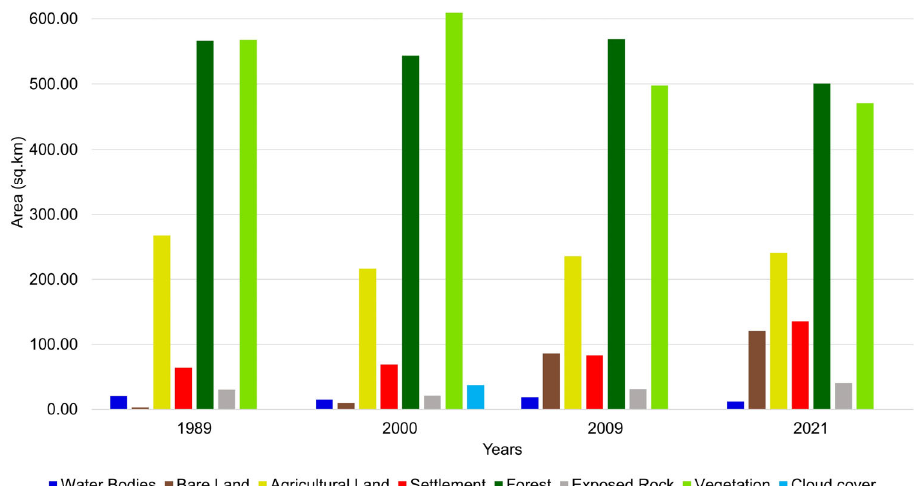
Figure 6. Variations of LU/LC types in Maha Oya River Basin from 1989 to 2021.